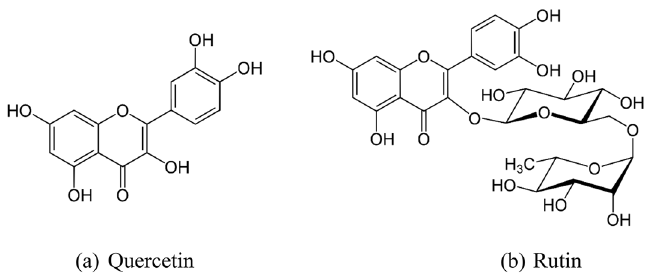
Fig. 1 Structure of Quercetin (“Quercetin,” 2022) and rutin (“Rutin,”